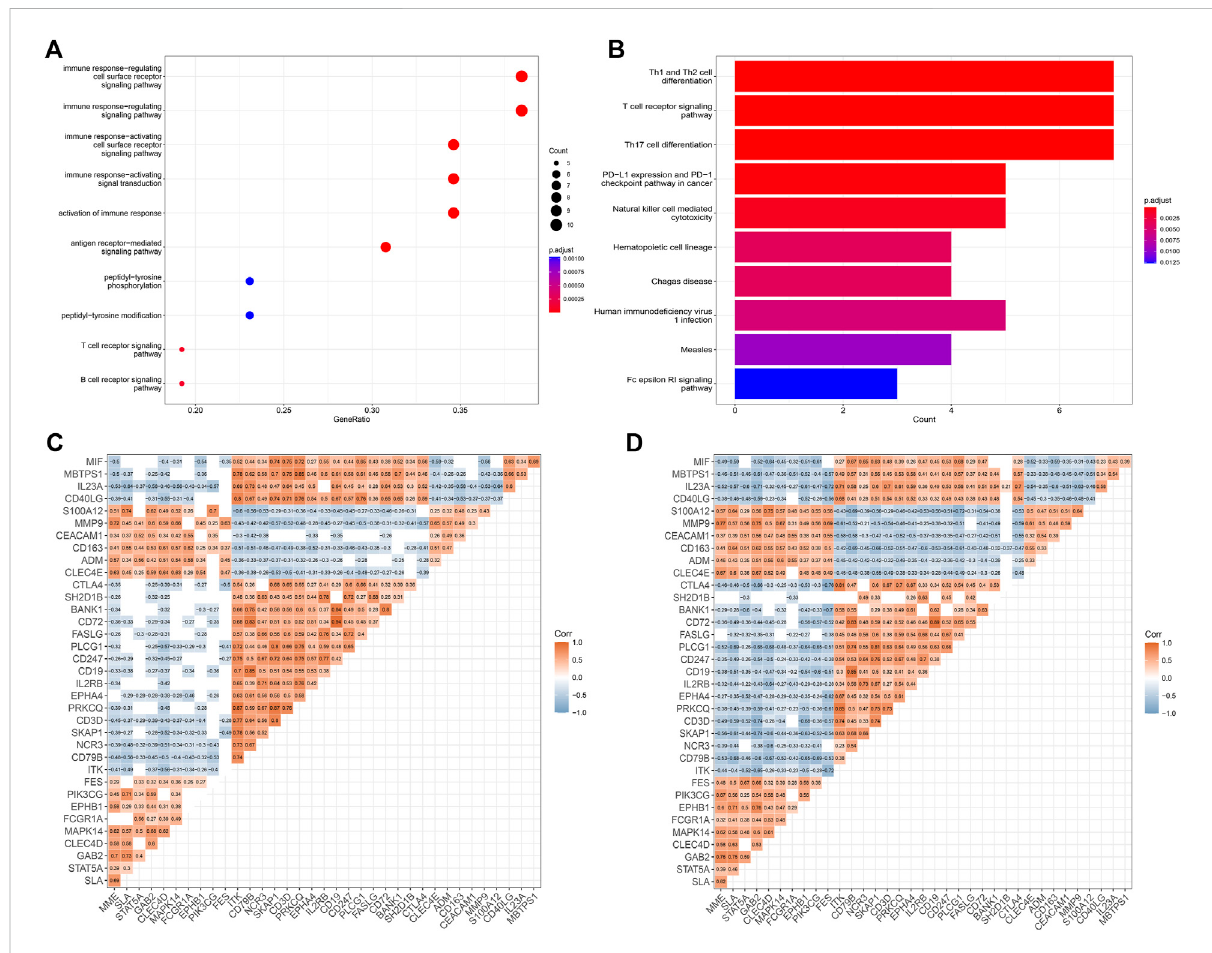
FIGURE 3 EnrichmentandcorrelationanalysesofpotentialISimmunebiomarkers. (A) GOanalysisofpotentialISimmunebiomarkers. (B) KEGGanalysisof potential IS immune biomarkers. (C,D) Heatmap showing the correlation analysis of potential IS immune biomarkers in the GSE16561 and GSE58294datasets.Thecorrelationcoef fi cient(Corr)wasdeterminedviaPearson ’ scorrelationanalysis.Blankspacesindicatethatcorrelationswere not statistically signi fi cant ( p >